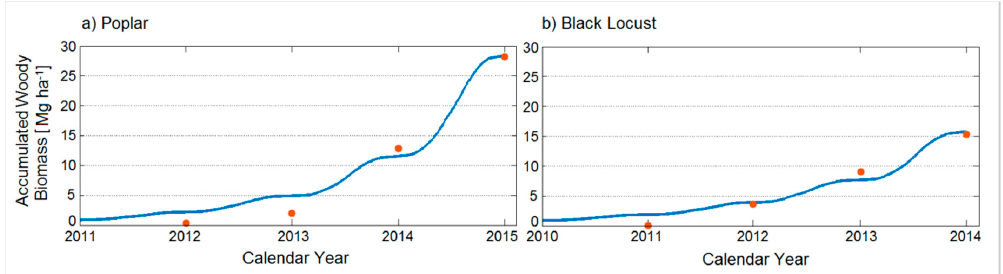
Figure 2. Measured woody biomass (dots) and modelled accumulated woody biomass (line) for: ( a ) poplar over a rotation period from 2011 to the end of 2014, and with regard to the planting density and number of samples ( n = 50:333) and ( b ) black locust over a rotation period from 2010 to the end of 2013, and with regard to the planting density and number of samples ( n =